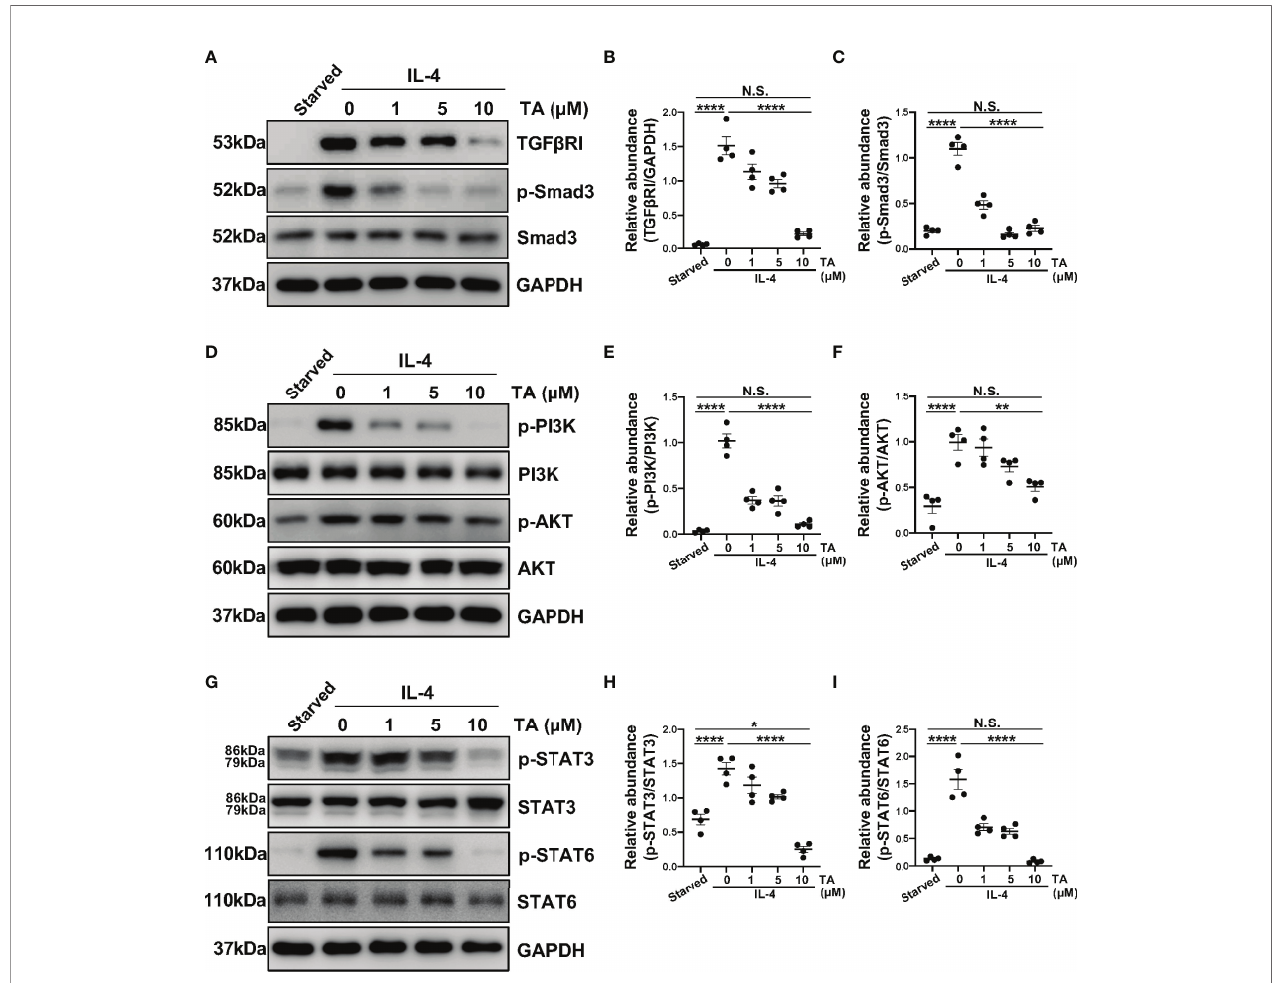
FIGURE 8 | TA inhibits M2 macrophage polarization via suppressing TGF- b 1/Smad3, PI3K/AKT, STAT3 and STAT6 signaling in Raw264.7 cells stimulated by IL-4. (A) Western blot analysis showed the levels of TGF b RI, p-Smad3, Smad3, and GAPDH in IL-4-stimulated Raw264.7 cells treated with different doses of TA. Expression levels of (B) TGF b RI and (C) p-Smad3 in different groups were quanti fi ed by densitometry and normalized with GAPDH and Smad3 respectively. (D) Western blot analysis showed the levels of p-PI3K, PI3K, p-AKT, AKT and GAPDH in IL-4-stimulated Raw264.7 cells treated with different doses of TA. Expression levels of (E) p-PI3K and (F) p-AKT in different groups were quanti fi ed by densitometry and normalized with PI3K and AKT respectively. (G) Western blot analysis showed the levels of p-STAT3, STAT3, p-STAT6, STAT6, and GAPDH in IL-4-stimulated Raw264.7 cells treated with different doses of TA. Expression levels of (H) p-STAT3 and (I) p-STAT6 in different groups were quanti fi ed by densitometry and normalized with STAT3 and STAT6 respectively. Data were expressed as means ± SEM. *P<0.05, **P<0.01. NS: P ≥